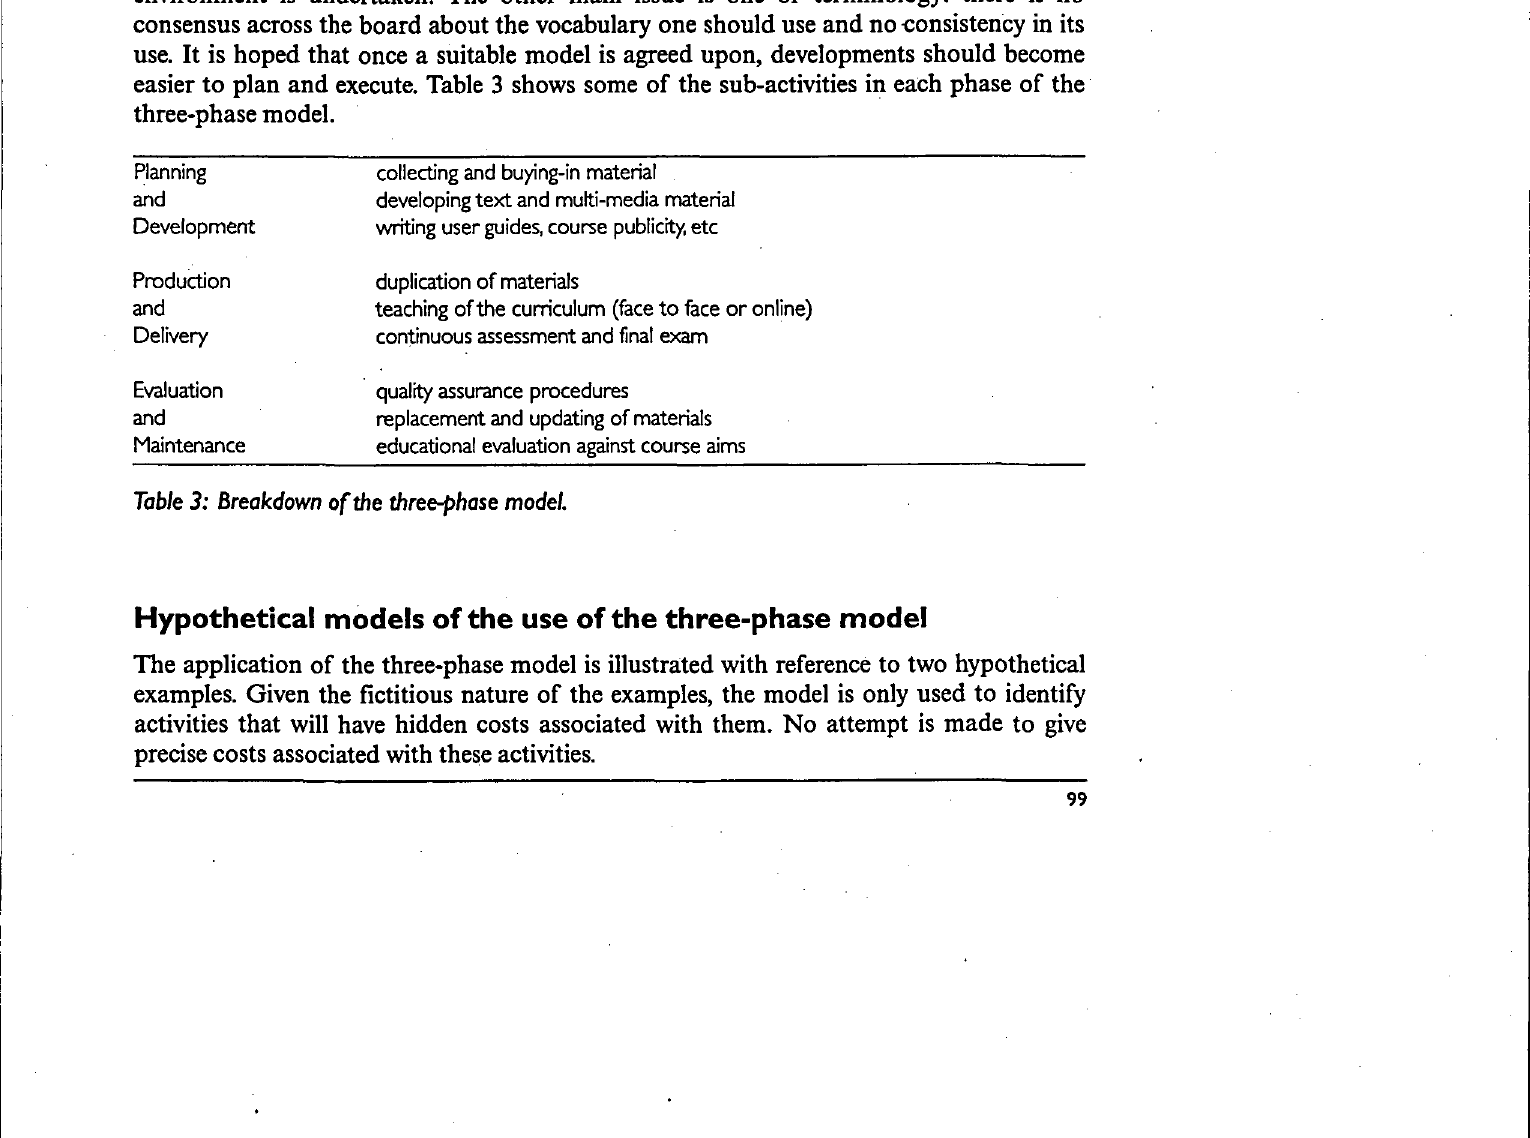
Table 3: Breakdown of the three-phase model.